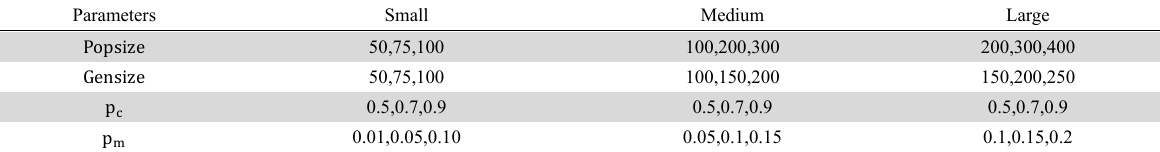
M-NSGA-II algorithm parameters and levels